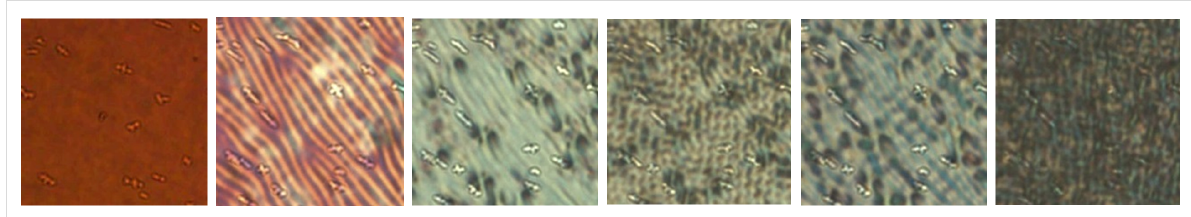
Figure 4: Polarized optical microscopy (POM) texture of a 7.8 µm BCN66 cell with an applied peak voltage of an AC square wave of 100 Hz. The original left-most texture is not affected by the AC voltage applied up to 10 V. Other textures were taken at the following voltages (from left to right): 11 V, 13 V, 20 V, 25 V, 30